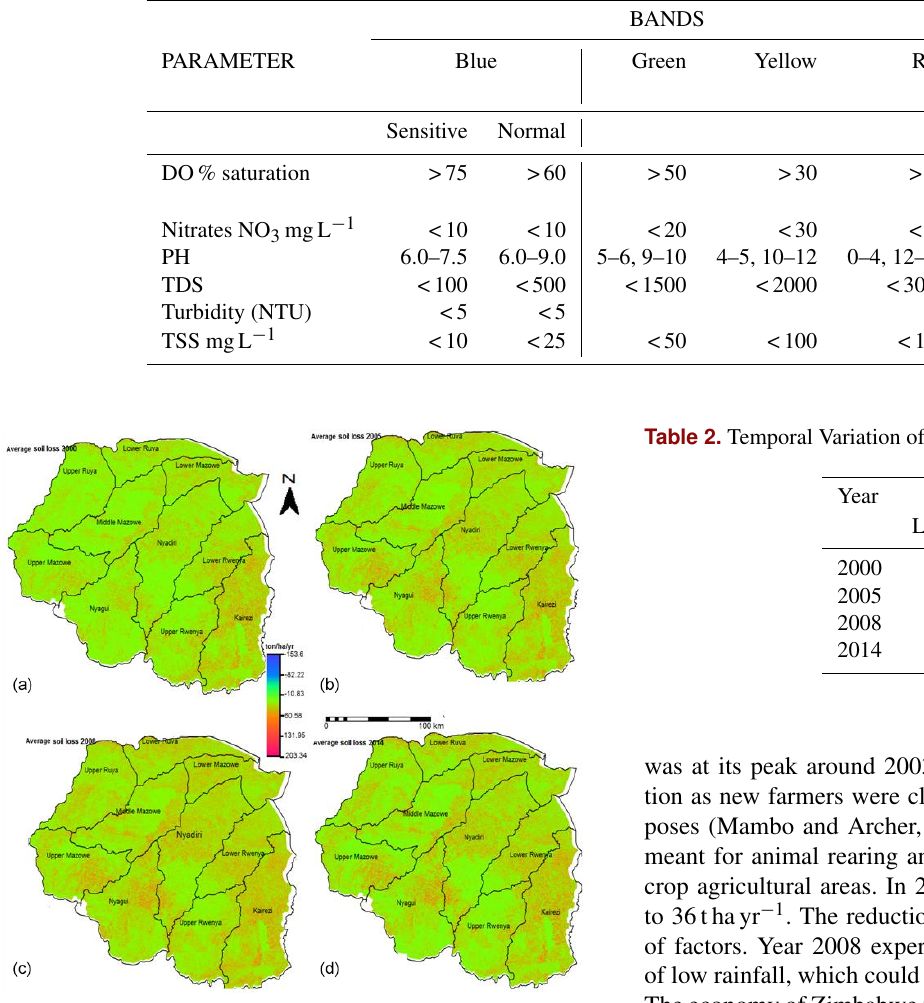
Figure 3. Estimated Average Soil Loss for 2000, 2005 2008, and 2014.